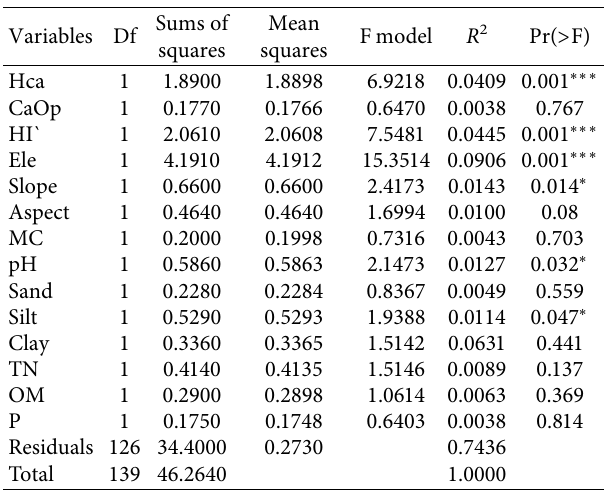
Table 10: Result of the function Adonis test of signifcant envi- ronmental and disturbance factors in